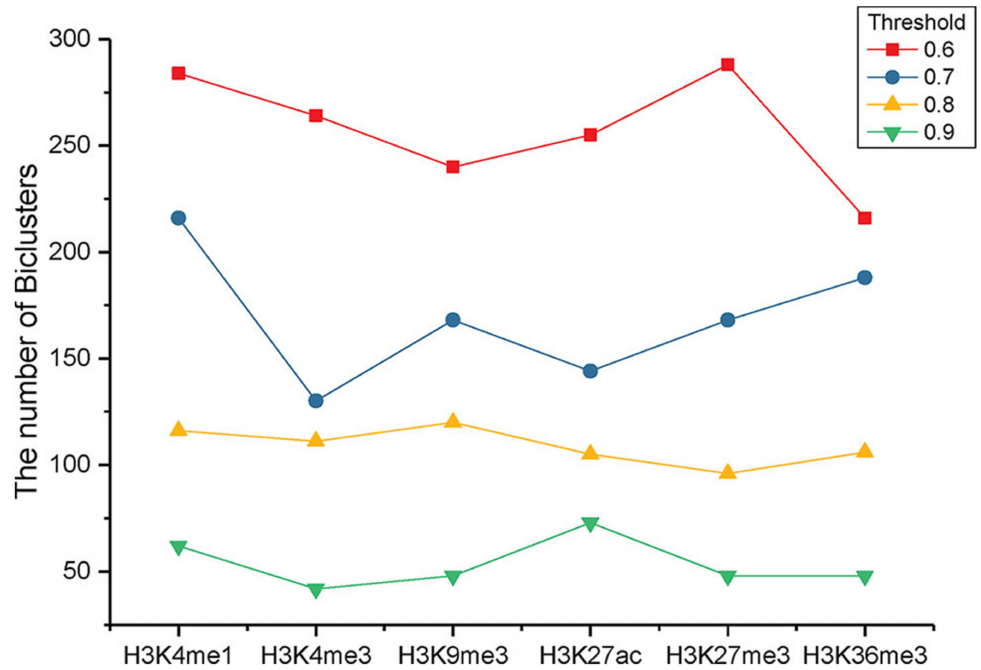
Figure 4. Experimental results of the bi-clusters thresholds versus various gene patterns. The comparison specifies that the correspondences of the epigenetic patterns are quite different. H3K4me3 has a small number of bi-clusters, while H3K4me1 and H3K27me3 have similar patterns across various cancer